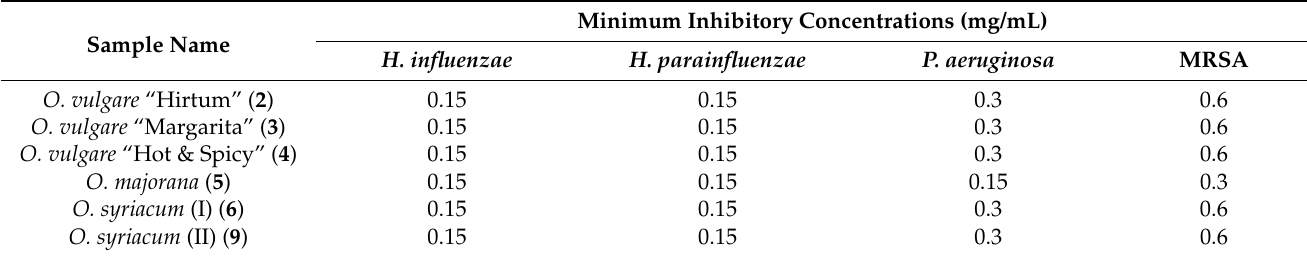
Table 2. Minimum inhibitory concentrations (MICs) of examined oregano essential